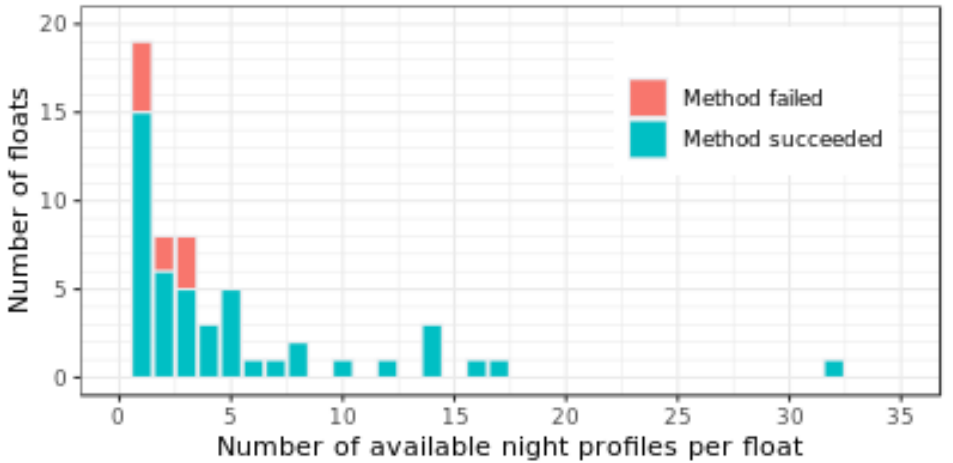
Figure 9. Number of floats with dark measurements successfully corrected for the four radiometric channels as a function of available night profiles.